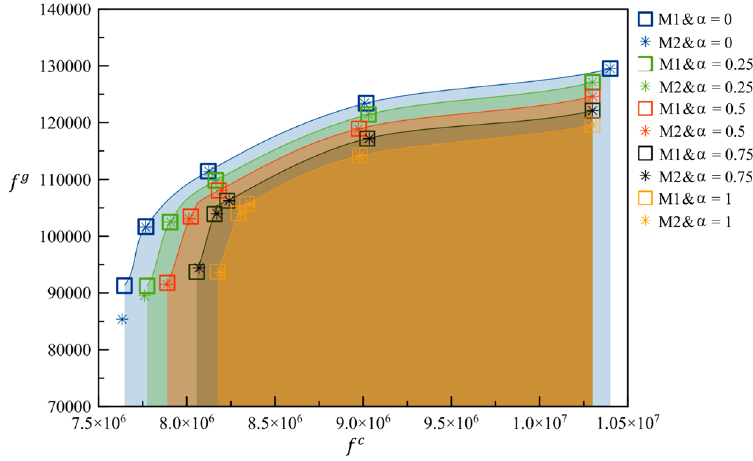
0.5Fig. 4. The estimated Pareto (near-Pareto)